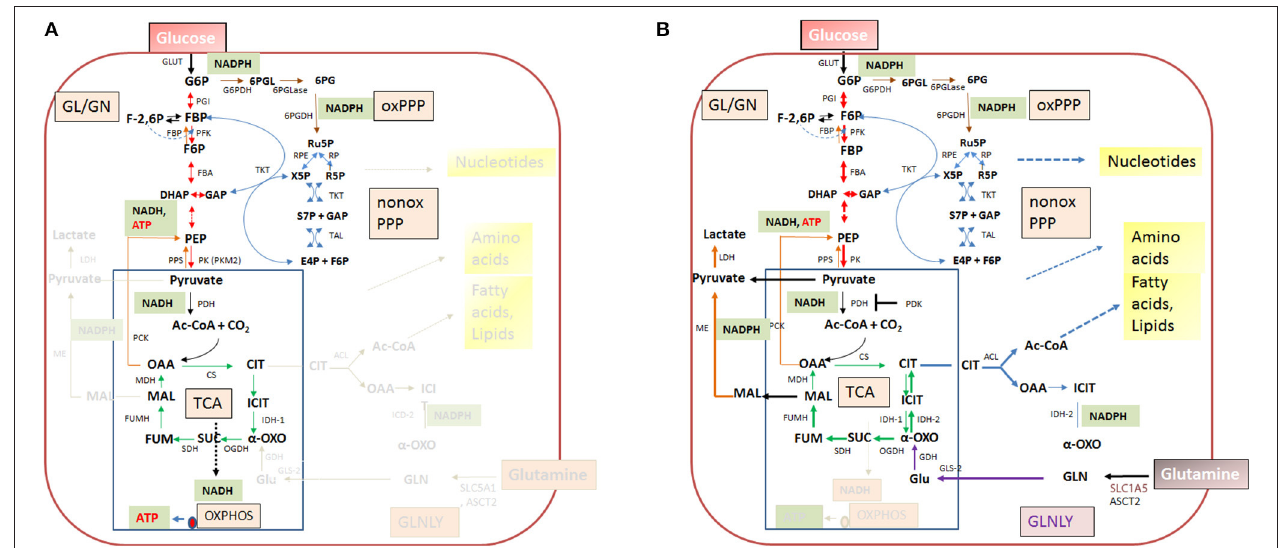
FIGURE 4 | Quiescent (A) and activated (B) metabolism in differentiated mammalian cells. In differentiated mammalian cells, including mucosal epithelial cells (MEC) and non-activated immune cells, the metabolism is characterized by low catabolic and anabolic activities. Low carbon fluxes fed by glucose and/or fatty acids run through glycolysis, PPP, and the TCA cycle; oxidative phosphorylation (OXPHOS) is the predominant source of ATP. The metabolism of metabolically activated cells (B) is characterized by enhanced glucose uptake, highly activated (“aerobic”) glycolysis, reduced entrance of pyruvate into the TCA cycle and reduced OXPHOS. ATP is mainly produced by substrate phosphorylation in the glycolytic pathway. In addition these cells show often increased glutaminolysis which replenishes the TCA cycle, leading to citrate (eventually via reverse IDH) which is transported into the cytosol where it is converted by the ATP-dependent citrate lyase (ACL) into oxaloacetate and acetyl-CoA, two metabolites serving for biosynthesis of fatty acids/lipids and amino acids. ß-oxidation is inhibited. Metabolites of GL: G6P, glucose-6P; F6P, fructose-6P; FBP, fructose-1,6 biphosphate; DHAP, dihydroxyacetonephosphate; GAP, glyceraldehyde-3P; PEP, phosphoenolpyruvate. Metabolites of the PPP: 6PGL, 6-phosphogluconolactone; 6PG, 6-phosphogluconate; Ru5P, ribulose-5P; X5P, xylulose-5P; R5P, ribose-5P; S7P, sedoheptulose-7P; E4P, erythrose-4P. Metabolites of the tricarboxylic acid (TCA) cycle: OAA, oxaloacetate; CIT, citrate; ICIT, Isocitrate; α -OXO, alpha-oxoglutarate; SUC, succinate, FUM, fumarate, MAL, malate. Enzymes of the GL: GLUT, glucose transporter; PGI, phosphoglucoisomerase; PFK, phosphofructokinase; FBA, fructobisphosphate aldolase; PK, pyruvatekinase. PDH, pyuvate dehydrogenase. LDH, lactate dehydrogenase. Enzymes of the PPP: G6PDH, glucose-6P dehydrogenase; 6PGLase, 6-phosphogluconolactonase; 6PGDH, 6-phosphogluconate dehydrogenase; RPE, Ru5P-epimerase; RPI, Ru5P-isomerase; TKT, transketolase; TAL, transaldolase. Enzymes of the TCA cycle: CS, citrate synthase; ICD, isocitratedehydogenase; OGDH, oxoglutarate dehydrogenase; SDH, succinate dehydrogenase; FUMH, fumarate hydratase; MDH,